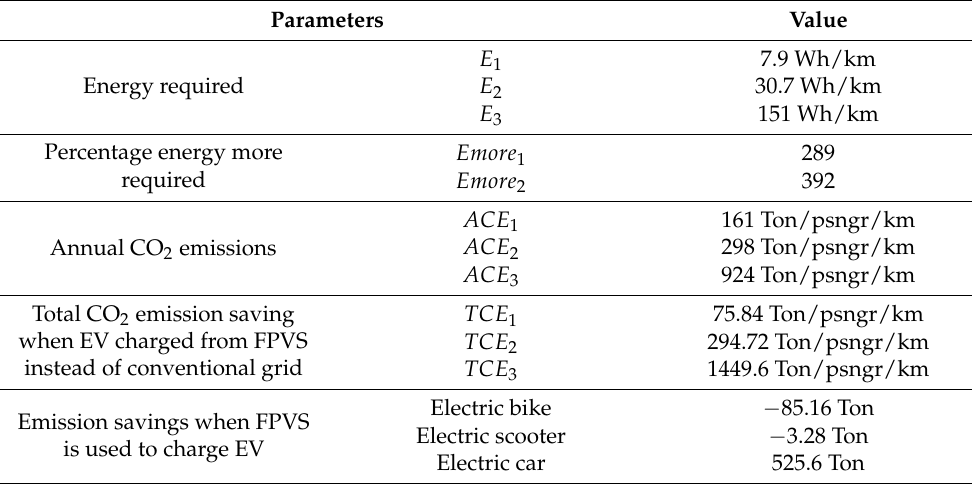
Table 4. CO 2 emission parameters assuming constant distance